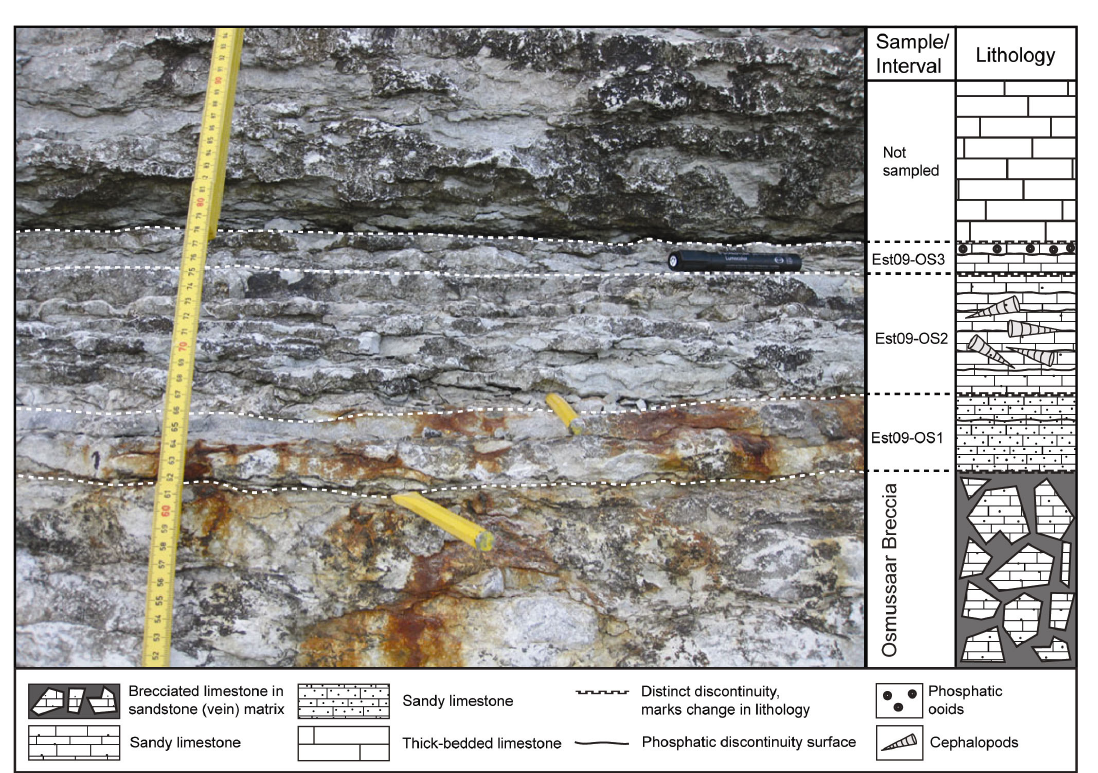
Fig. 3. Photograph and log over the sampled Osmussaar section. Dotted lines (white in the photograph) mark sample interval boundaries. For details, see the legend and the (cid:145)Materials and Methods(cid:146) and (cid:145)Results(cid:146)